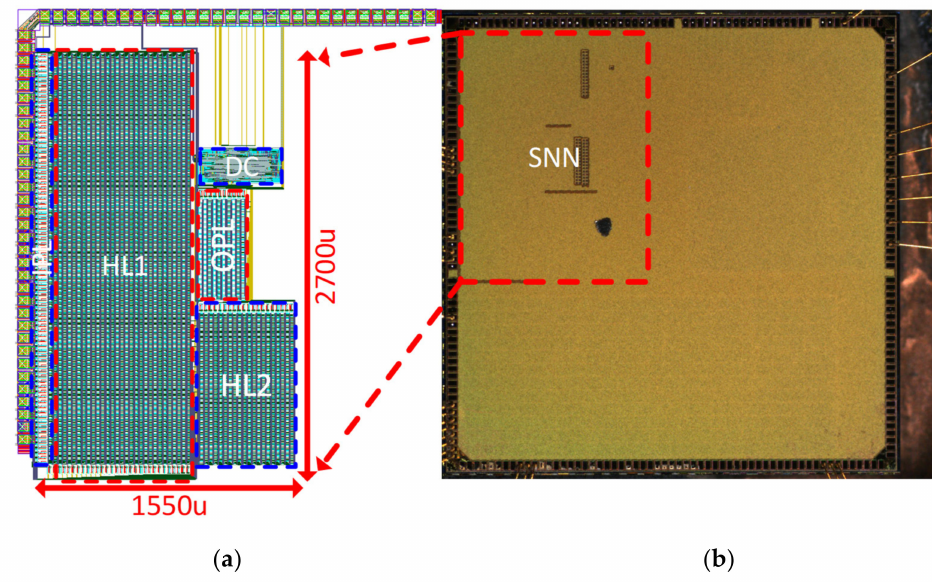
Figure 9. ( a ) The complete layout of the SNN implementation constituting of 4 fully connected layers with area estimation; ( b ) The bonded die micrograph highlighting the fabricated SNN